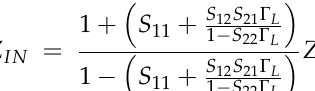
Figure 9. The simulation and measured results of S-parameters.